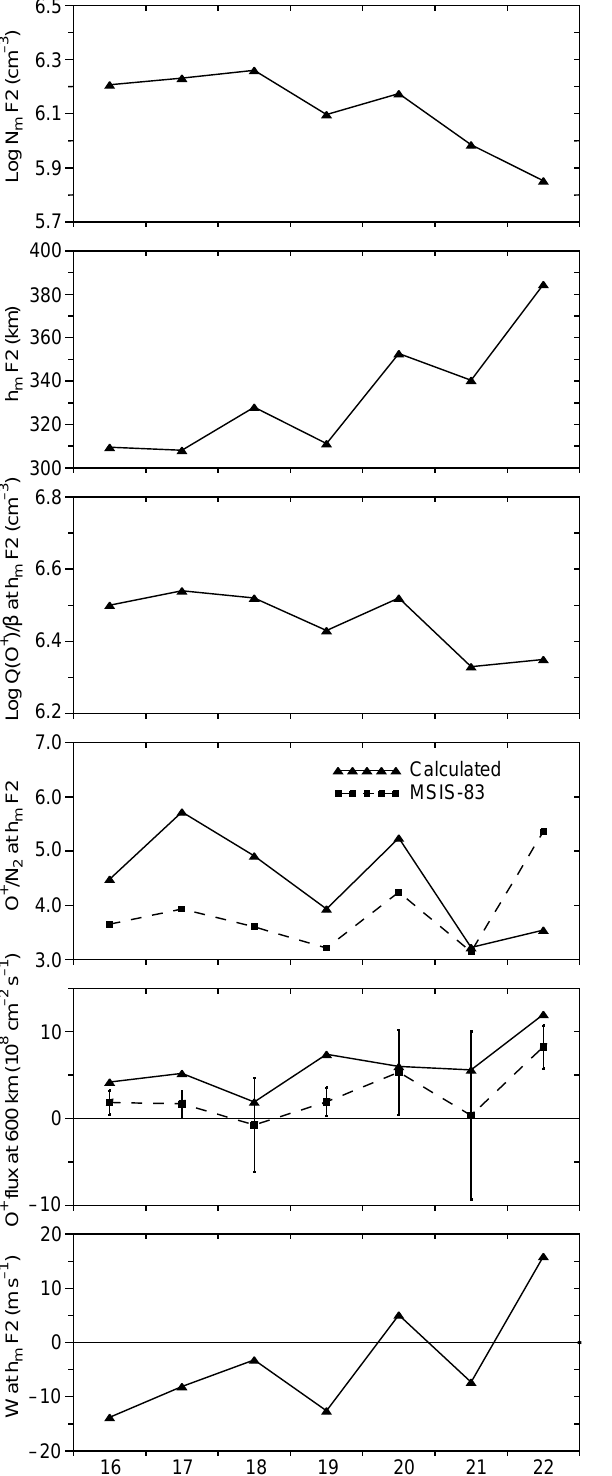
Fig. 6. Calculated (triangles), Millstone Hill estimated (squares) and MSIS–83 predicted (dashes) exospheric temperature T ex . Calculated (triangles) along with the MSIS–83 predicted (dashes) O, N 2 and O 2 variations at 300 km. Calculated values (triangles) in comparison with Millstone Hill estimates (squares) of meridional (along the magnetic meridian) thermospheric wind (positive to the south). Figures along the x axis (UT) are dates of